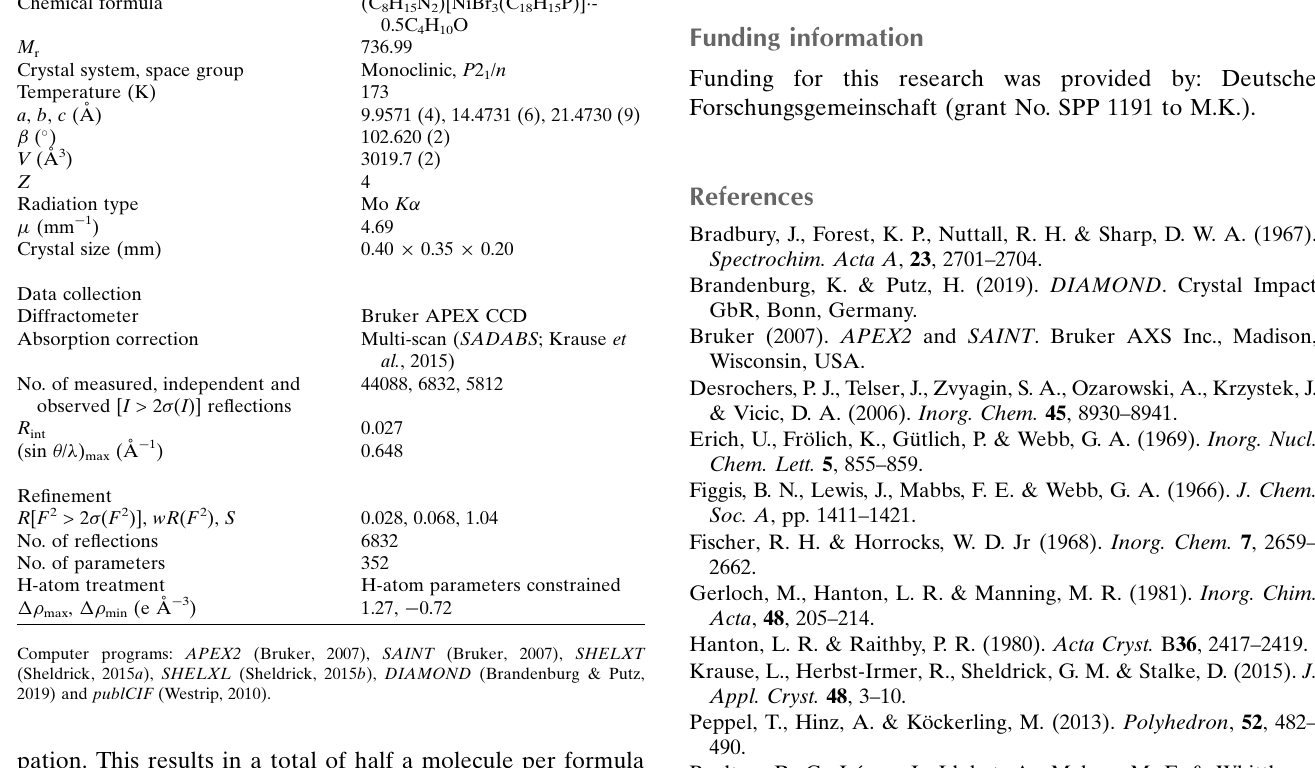
Table 2 Experimental details. Crystal data Chemical